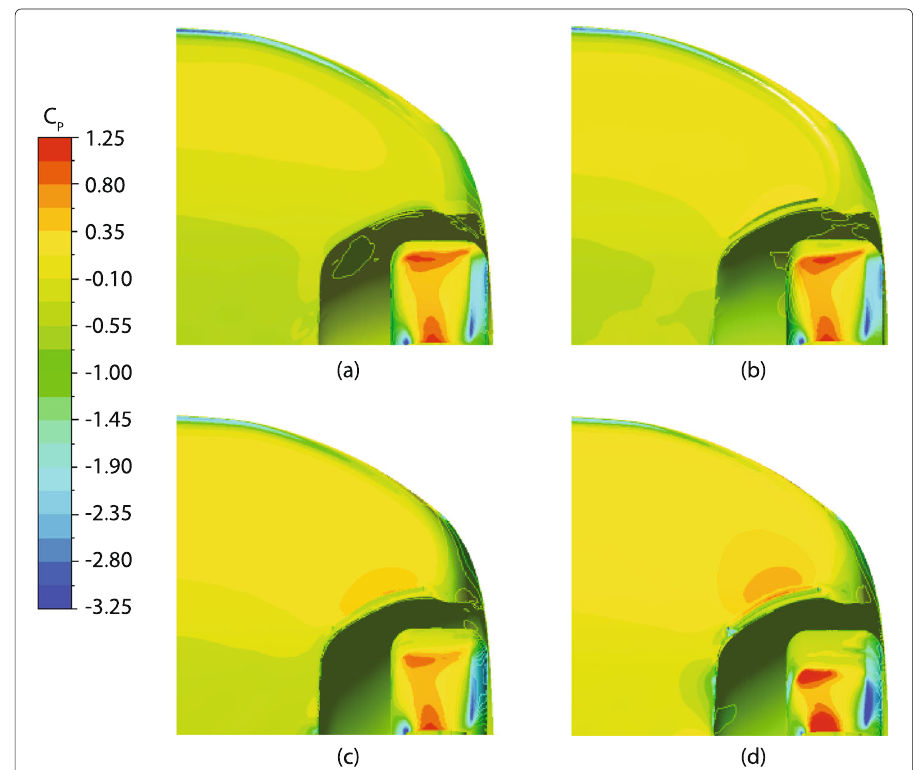
Fig. 15 Pressure coefficient contours on the underside of the front left wheel and surrounding area of the notchback DrivAer reference model at U ∞ = 15 m/s ( a ) baseline, ( b ) 90 ◦ air jet with U = 1/3, ( c ) 90 ◦ air jet with U = 3/3, and ( d ) 90 ◦ air jet with U =